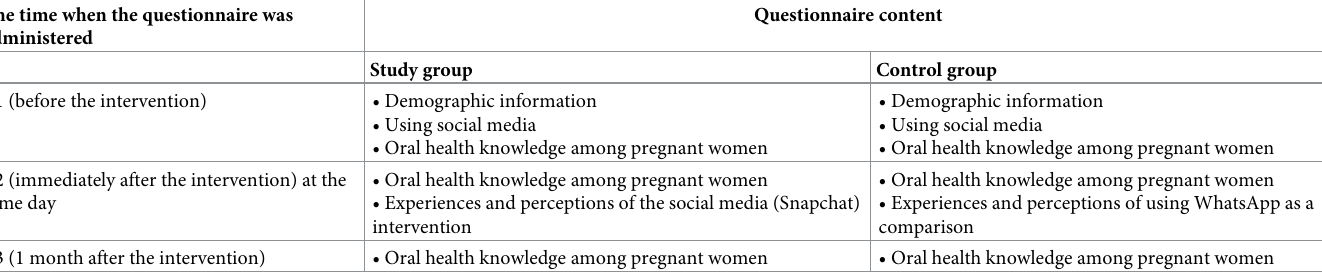
Table 1. Contents of questionnaire at T1, T2, and